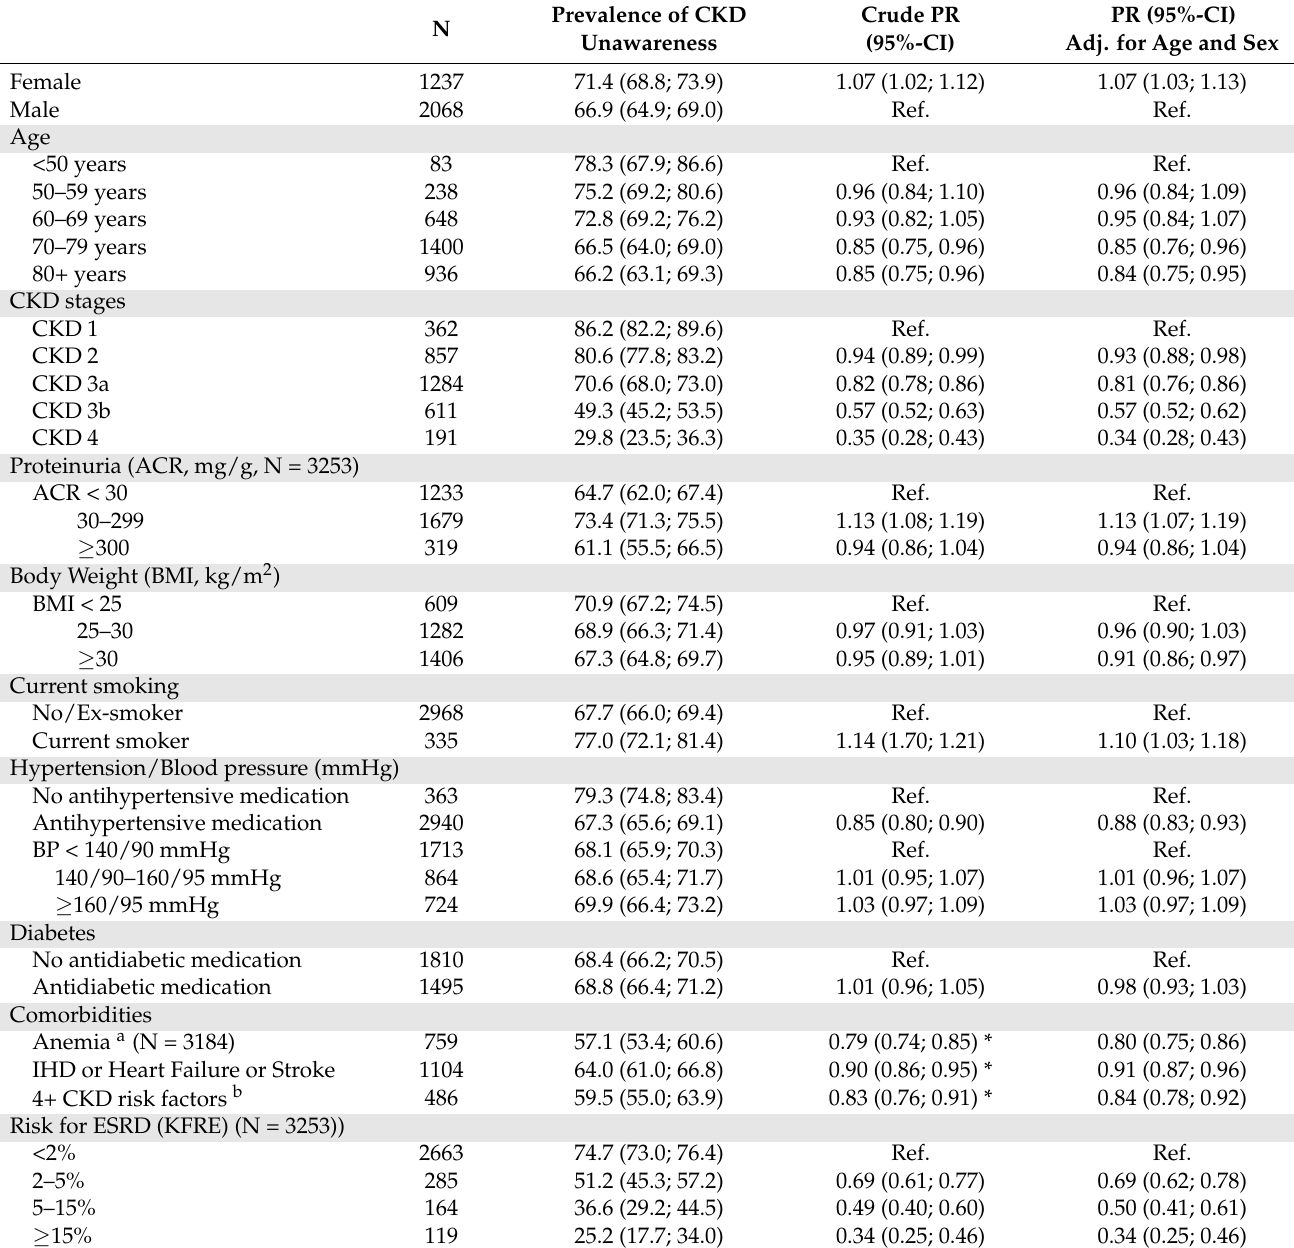
Table 2. Unawareness for chronic kidney disease (CKD) Stages 1 to 4 by patients’ characteristics. Crude, and age and sex adjusted prevalence ratios (PR) and 95% confidence intervals (CI) for risk of unawareness. PR for sex adjusted for age, and PR for age adjusted for sex. German CKD cohorts (CORE database),